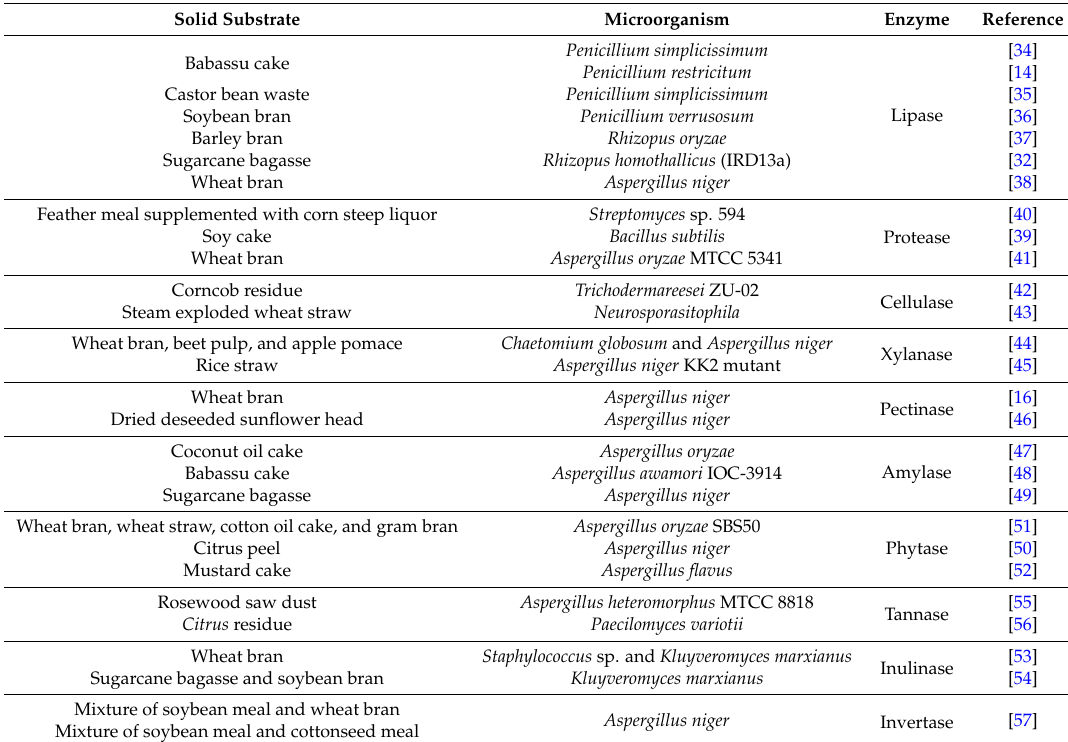
Table 1. Production of industrial biocatalysts by Solid-State